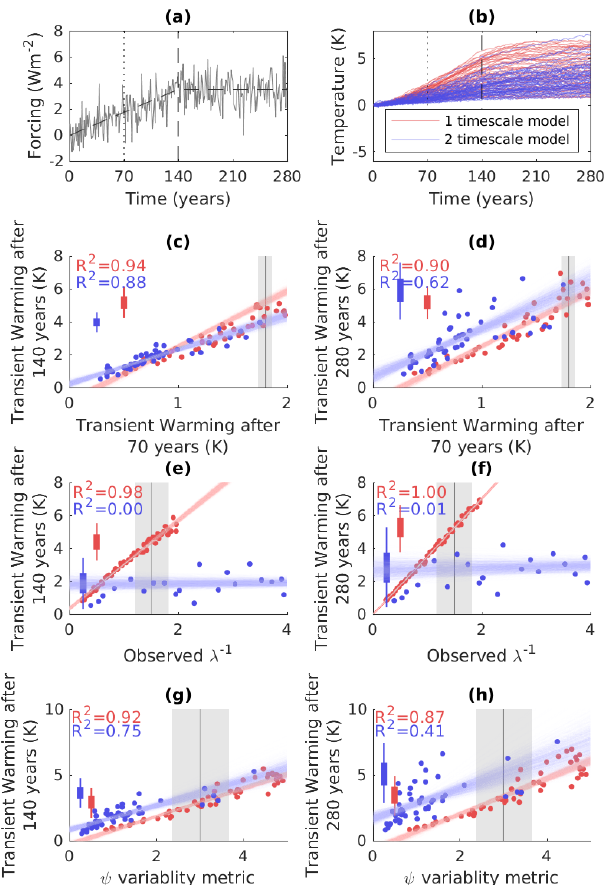
Figure 1. An illustration of the three kinds of emergent constraint in two structurally different ensembles. (a) An idealised forcing time series used for each of the simulations – a (noisy) linear ramping of radiative forcing from years 0–140 followed by (noisy) con- stant forcing from years 140–280. Panel (b) shows the response in 50-member perturbed parameter ensembles of two energy bal- ance models with one (red) and two (blue) timescales of response. (c) A constraint of the first kind showing TCR (warming after 70 years of 1% annual increase in CO 2 concentrations) as a predic- tor of T140 (warming at time of CO 2 quadrupling, 140 years in the same experiment). (d) Warming after a further 140 years of con- stant (quadrupled) CO 2 concentrations. (e, f) Constraints of the sec- ond kind using the feedback parameter “lambda” to predict warm- ing after (140, 280) years. (g, h) Constraints of the third kind us- ing a variability metric (Cox et al., 2018b) derived from detrended temperature time series in years 1–70 as a predictor warming after (140, 280) years. In each case, coloured points show members of the model ensemble, lines show bootstrap regression estimates, and grey vertical bars show the 10th, 50th and 90th percentile of the (hypothetical) observed uncertainty distribution. Coloured box and whisker plots show the 5 / 95th and 25 / 75th percentiles illustrating the prediction interval from each ensemble. Variance explained by the predictor for one- and two-layer models is printed in red and blue text